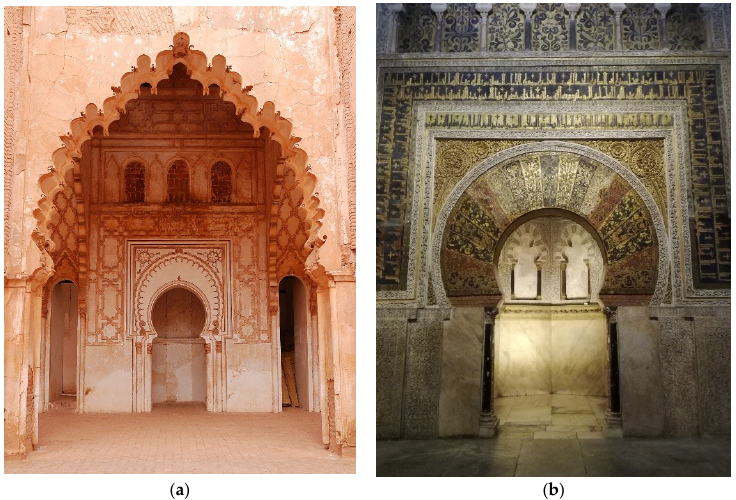
Figure 1. Facade of the mi ḥ rab of the mosque of Tinmāl ( a ). Photo in public domain (cc) Rosino (https://tinyurl.com/y75nyqrq). Detail of the facade of the mi ḥ rab of the Great Mosque of Cordova ( b ). Photo took by author. (https://tinyurl.com/y75nyqrq). Detail of the facade of the mih . rab of the Great Mosque of Cordova ( b ). Photo took by